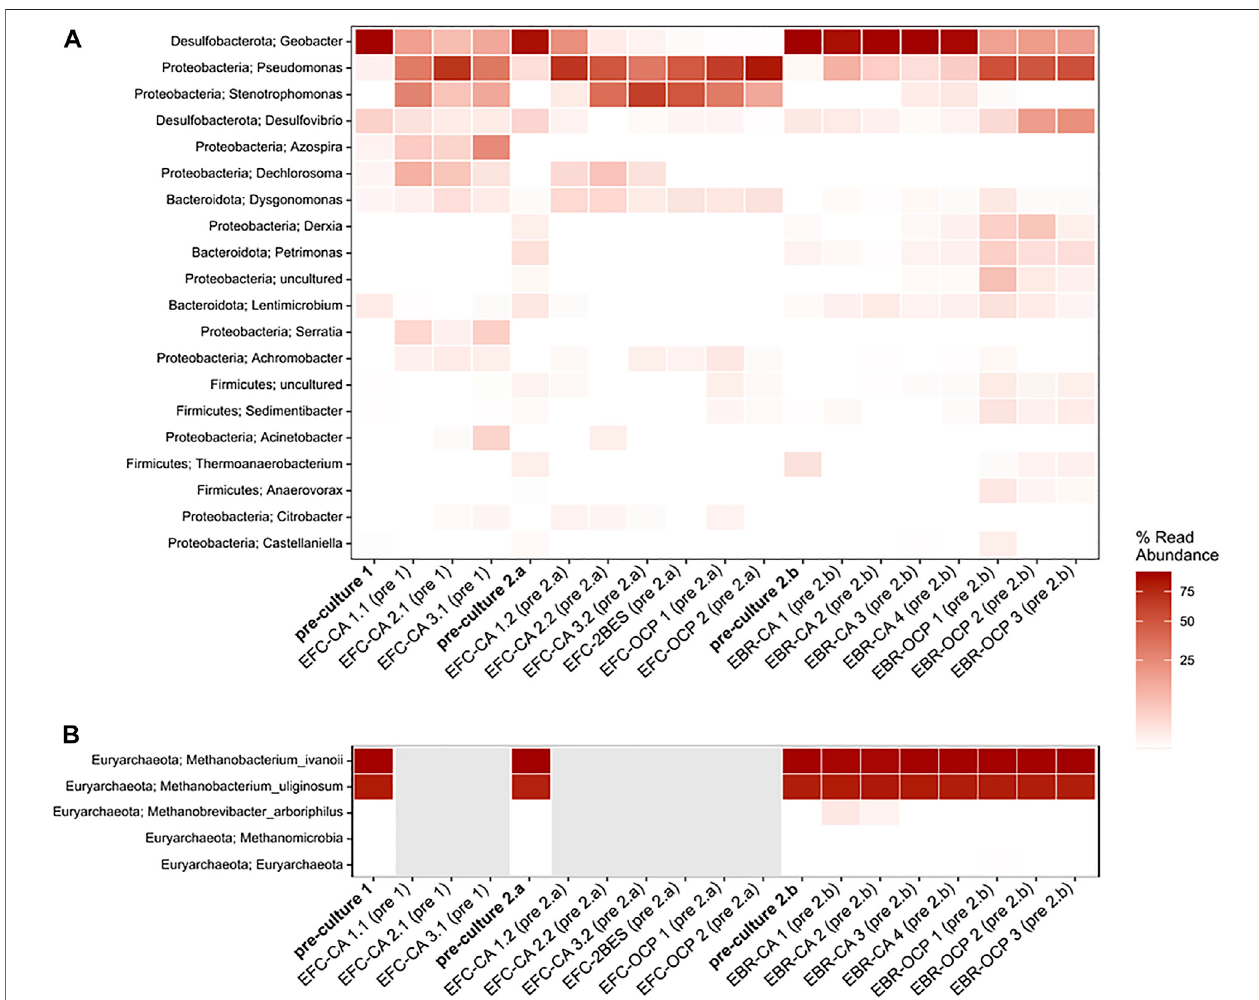
FIGURE3| Heatmapsshowingtherelativecommunitycompositionofbacteria (A) andmethanogenicarchaea (B) derivedfromtheILLUMINAsequencinganalysis of bacterial 16S rRNA genes and archaeal mcrA gene (B) . Gray boxes in (B) indicate samples where no methanogenic archaea were detected. Samples legend: pre- culture 1 and pre-culture 2 indicate the used pre-culture (or inocula); EFC: electrochemical fl ow-cell; CA: chronoamperometry; OCP: open circuit potential; EBR: electrochemicalbatchreactor( Section 2.1 );pre-culture 2aand 2bindicatetherespectiveinoculumthatwasusedforCAandOCP experiments, respectively,and refer to pre-culture 2. Numbers indicate the replicate